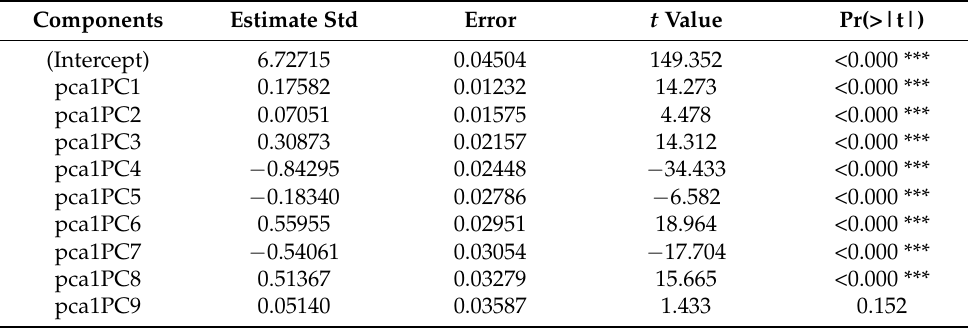
Table 9. Bottom teams linear regression